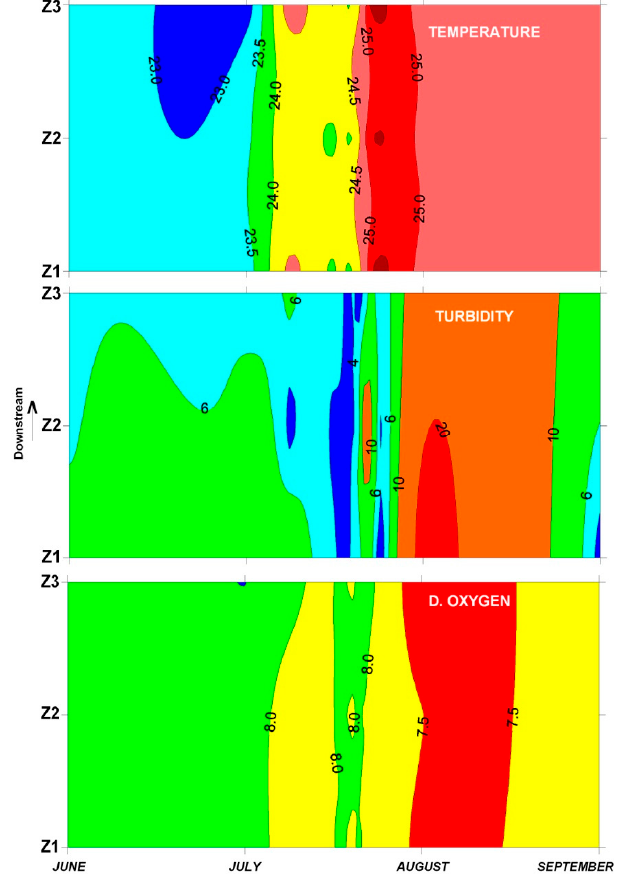
Figure 2. Spatial (Z1 through Z3) and temporal (June through September) distribution of key environmental descriptors: temperature (°C), turbidity (NTU) and dissolved oxygen (mg L − 1 ) at